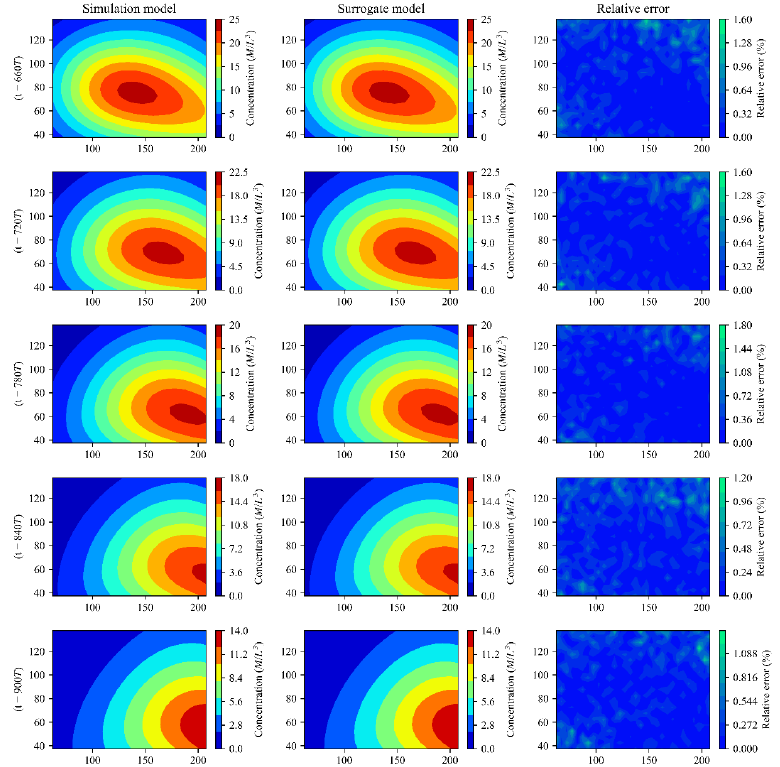
Figure 4. Outputs and relative error of simulation model and surrogate model for Case 1 (the x-axis and y-axis represent the length and width of the flow field, respectively).